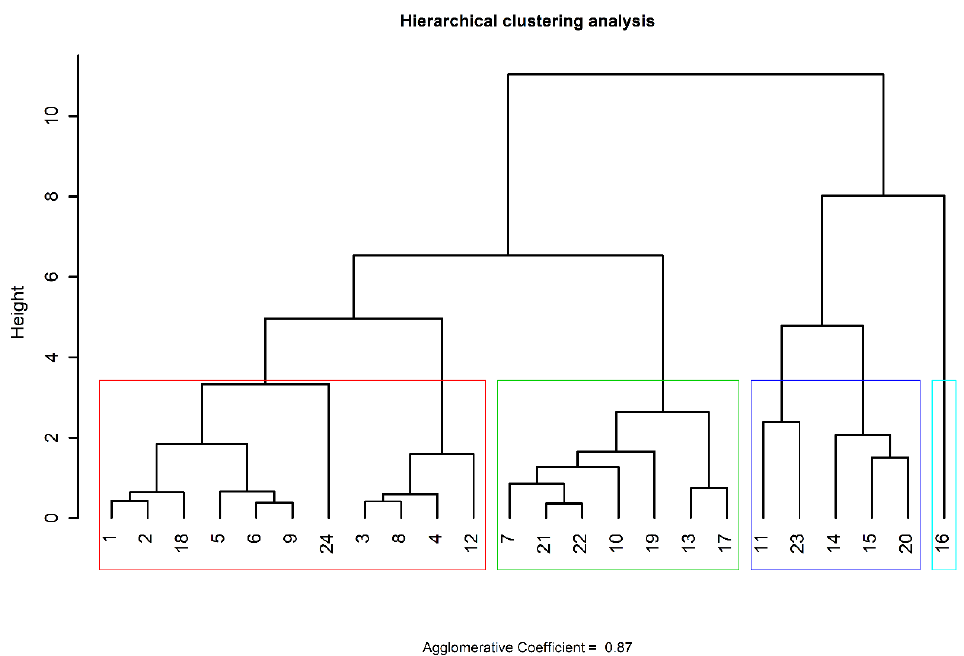
Figure 4. Agglomerative clustering analysis of the studied locations.